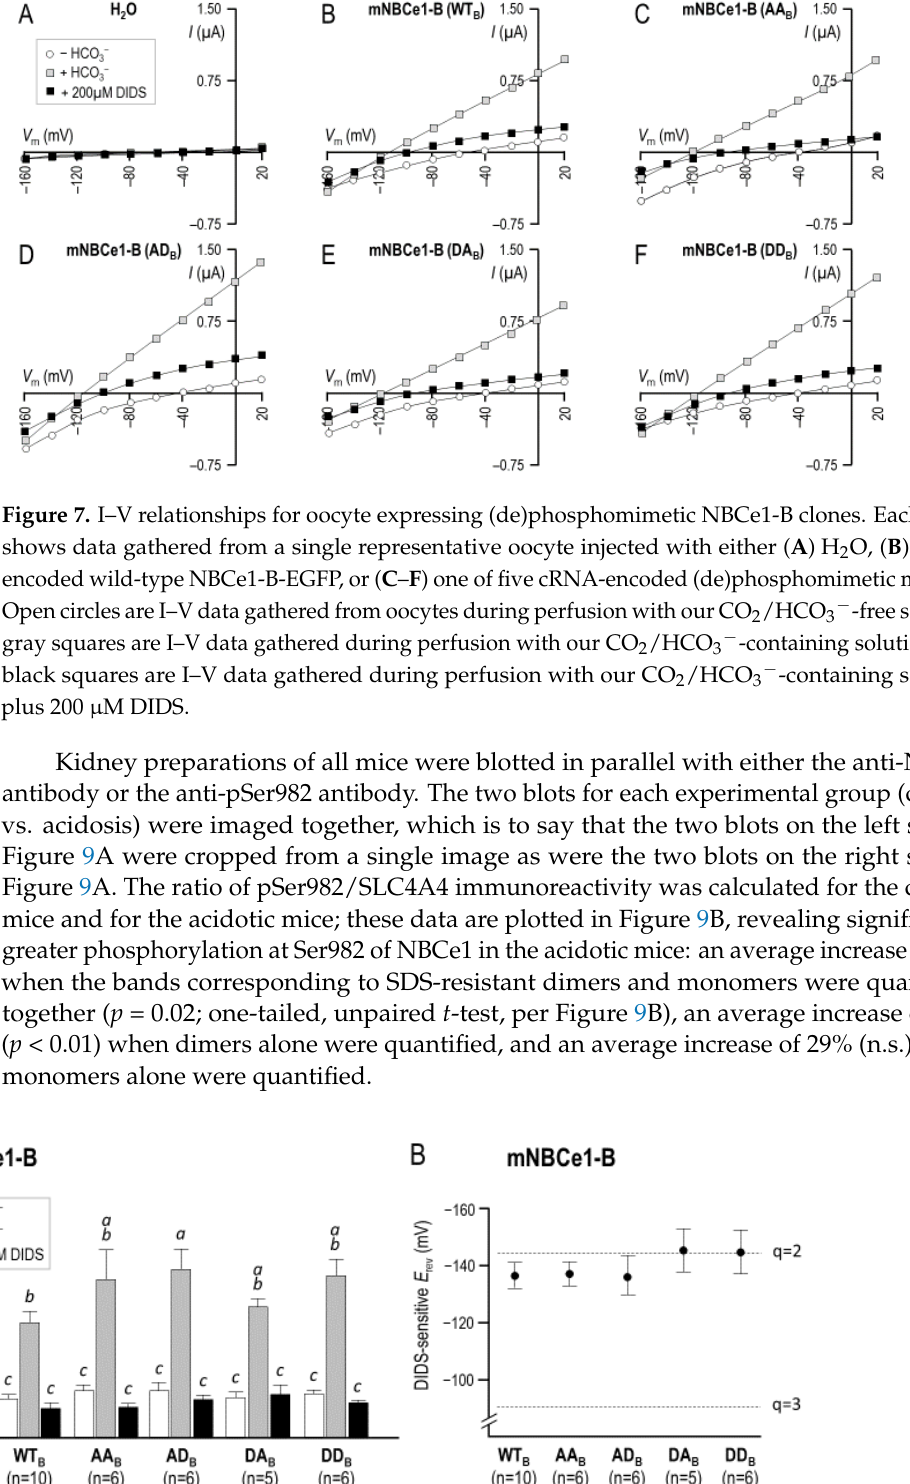
Figure 8. The conductance and stoichiometry of (de)phoshomimetic NBCe1-B clones in Xenopus oocytes. ( A ) The membrane conductance of a larger number of oocytes calculated from data, such as those show in Figure 7. Letters above bars indicate statistically indistinguishable groups (i.e., groups with different letter were significantly different from each other); ( B ) The reversal potentials of wild-type NBCe1-B and the four (de)phosphomimetic mutants plotted against the reversal potentials that correspond to predicted transport stoichiometries of 1Na + –3HCO 3 − ( q = 3) and 1Na + –2HCO 3 − ( q = 2). 2.4. The Relative Phosphorylation Status of NBCe1/Ser982 in Murine Kidneys after 24 h Meta- bolic Acidosis The greater extent of the phosphorylation at Ser982 in the kidney NBCe1 than in the colon NBCe1 is consistent with the hypothesis suggesting phosphorylation at this residue would correlate with NBCe1 activity. Therefore, we hypothesized that metabolic acidosis, a condition that requires an increase in renal HCO 3 − generation, could increase phosphor- ylation at Ser982 in renal NBCe1. Our study group included seven control mice and eight NH 4 Cl-dosed mice. We performed blood-gas analysis on five of our control mice and four of the NH 4 Cl-dosed mice to confirm induction of metabolic acidosis ([HCO 3 − ] = 25 ± 1 mM for control, 14 ± 1 mM for NH 4 Cl-dosed, p < 0.01; unpaired, one-tailed t -test.) Kidney preparations of all mice were blotted in parallel with either the anti-NBCe1 antibody or the anti-pSer982 antibody. The two blots for each experimental group (control vs. acidosis) were imaged together, which is to say that the two blots on the left side of Figure 9A were cropped from a single image as were the two blots on the right side of Figure 9A. The ratio of pSer982/SLC4A4 immunoreactivity was calculated for the control mice and for the acidotic mice; these data are plotted in Figure 9B, revealing significantly greater phosphorylation at Ser982 of NBCe1 in the acidotic mice: an average increase of 46% when the bands corresponding to SDS-resistant dimers and monomers were quanti- fied together ( p = 0.02; one-tailed, unpaired t -test, per Figure 9B), an average increase of 71% ( p < 0.01) when dimers alone were quantified, and an average increase of 29% (n.s.) when monomers alone were quantified.